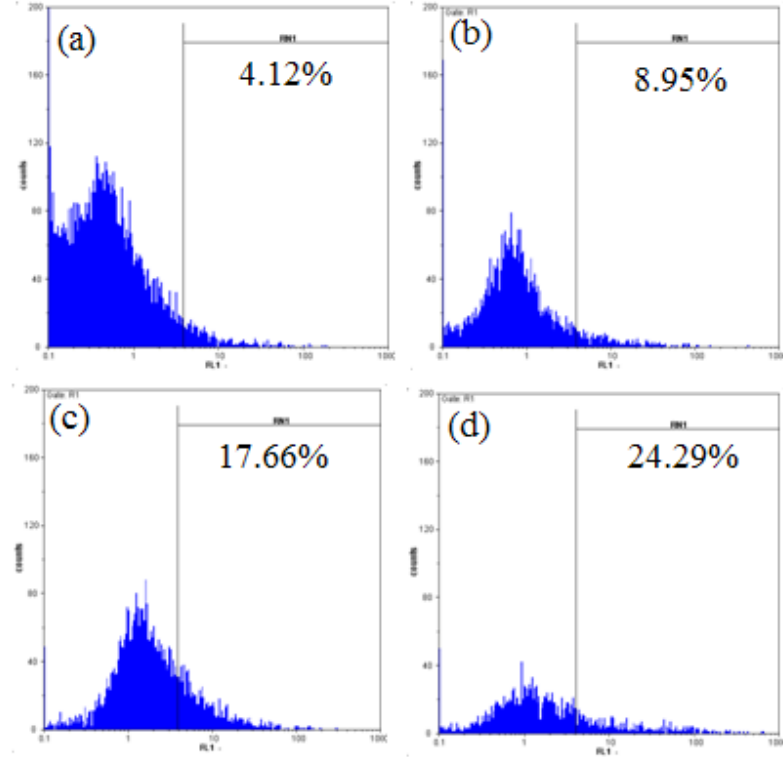
Figure 5. Effect of chamaejasmine on intracellular ROS formation in A549